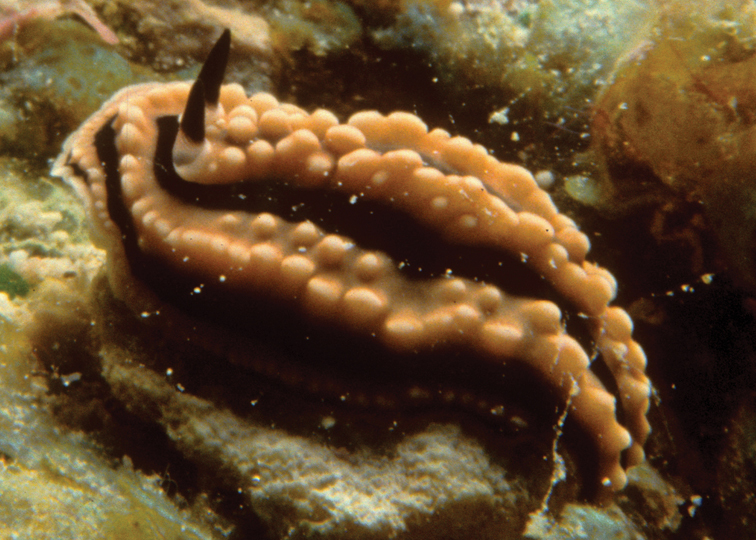
Phyllidiella zeylanica, 38 mm, Maldives, photo: H Debelius (spcm in Yonow 1996).